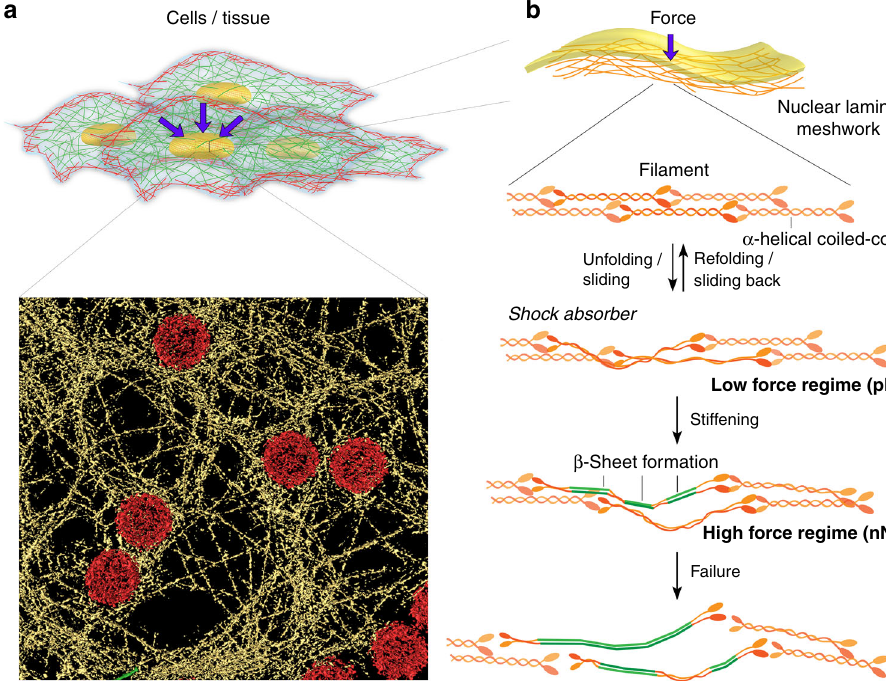
Fig. 7 Nuclear lamins under external forces. a The cell nucleus is under constant stress from its surroundings and experiences continuous or prolonged mechanical shocks during division and migration 93,94 . The nuclear lamina forms a meshwork that protects the genome and maintains the integrity of the nucleus. Surface-rendered view of the lamin meshwork in a MEF nucleus obtained by cryo-ET (adapted from ref. 4 ). b A schematic model based on in vitro AFM measurements showing the response of lamin fi laments when subjected to different levels of external force. Based on the experiments compressing the nuclei (Supplementary Fig. 20 and 21), we speculate that the meshwork topology probably plays a role in lamina mechanics. Whether the fi laments undergo a similar fate during compression as observed in point load in vitro experiments, will require further investigation. Purple arrows denote loads exerted on a